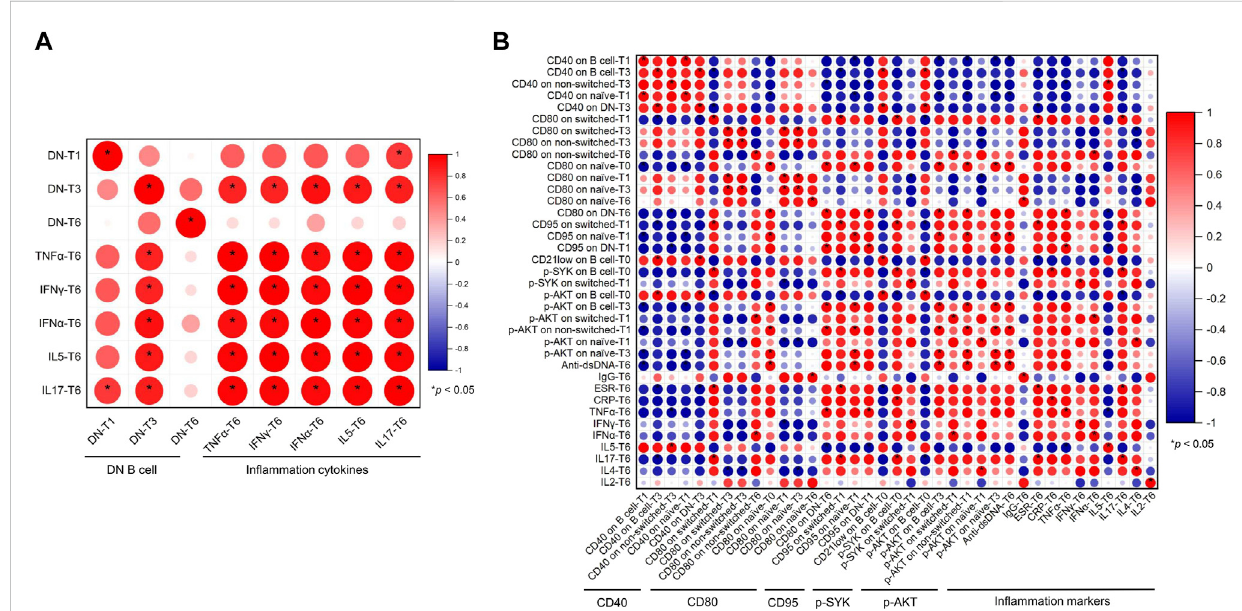
FIGURE 4 Correlation between B cells and clinical markers in the SLE patients. (A) Correlation between DN B cells and in fl ammation cytokines. (B) Correlation betweenB-cellactivationregulatorsandanti-dsDNA,IgG,andin fl ammationmarkers.Abbreviations:CRP,C-reactiveprotein;DN,double-negative;ESR, erythrocyte sedimentation rate; IL, interleukin; IFN, interferon; SLE, systemic lupus erythematosus; T, time; TNF, tumor necrosis